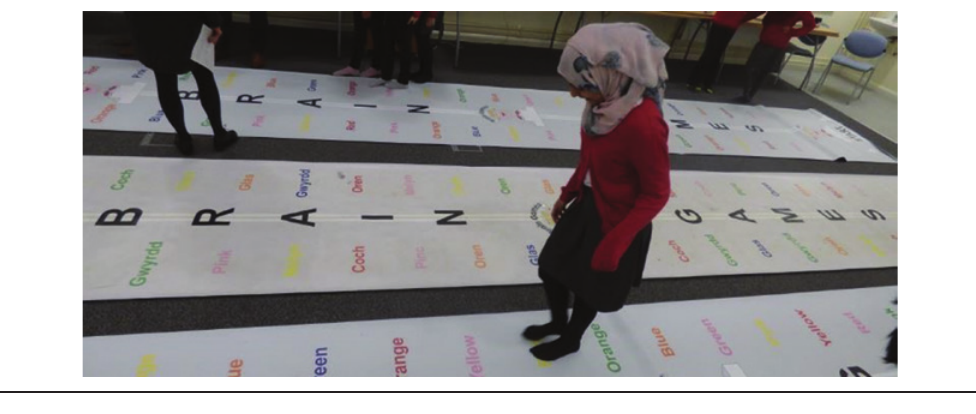
Figure 1: Pupils using the Stroop mats (source: author)